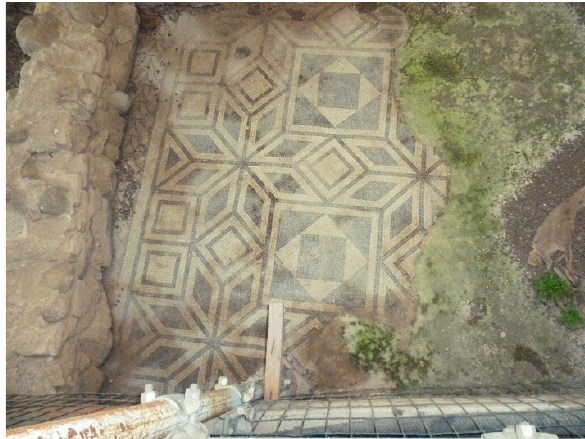
Figure 3: photo of a geometric